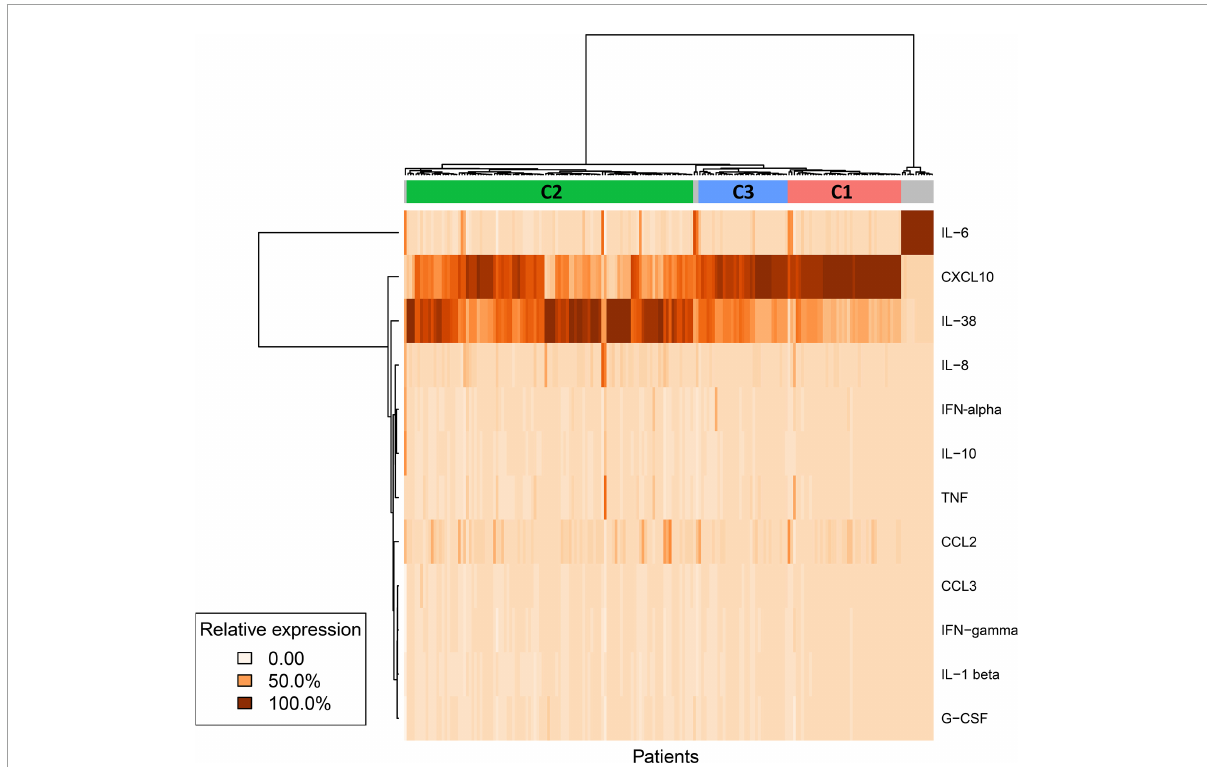
FIGURE2 Cytokine profile clustering. Using a machine learning approach, clustering of participants was performed based on their cytokine profile. Median value for each cytokine was used to create profiles or clusters (194 patients × 13 cytokines). The algorithm Hierarchical Clustering (HC) was implemented to define groups based on the similarity of the values of